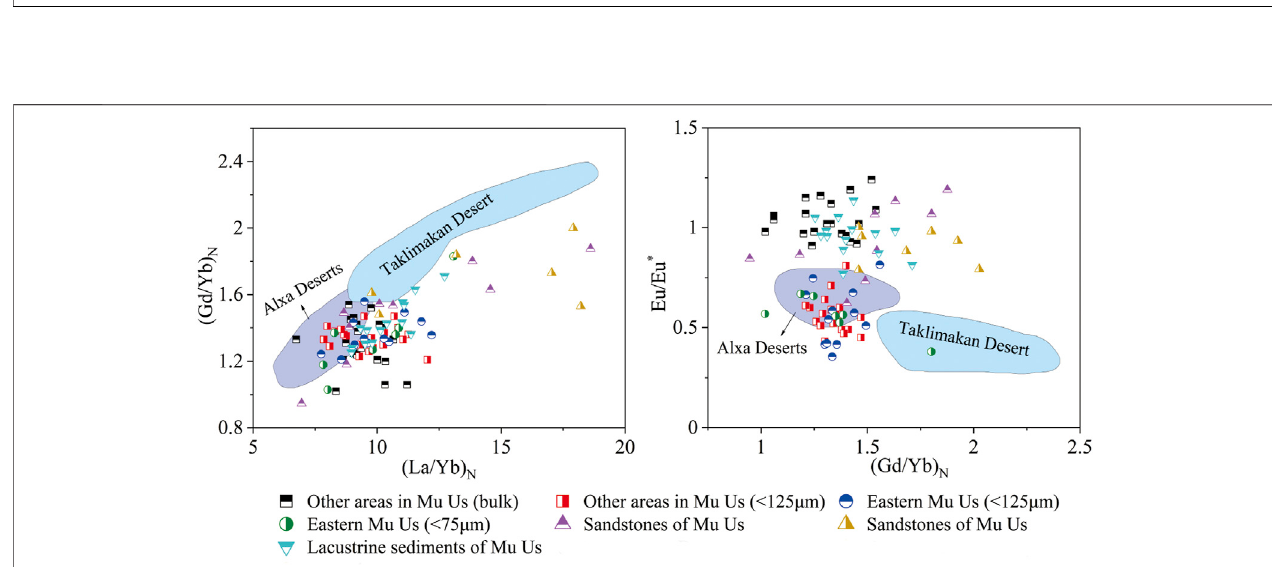
FIGURE 14 | Bivariate diagrams of geochemical elements ratios of samples from other areas of the Mu Us Sandy Land and their potential source areas. Data from otherstudies includethosefrom theeastern MuUs, sandstone, and lacustrinesedimentsoftheMu Us(Raoet al.,2011b;Liu andYang, 2018),thesands ofTaklimakan Desert and Alxa Deserts (Hu and Yang, 2016; Jiang and Yang, 2019).